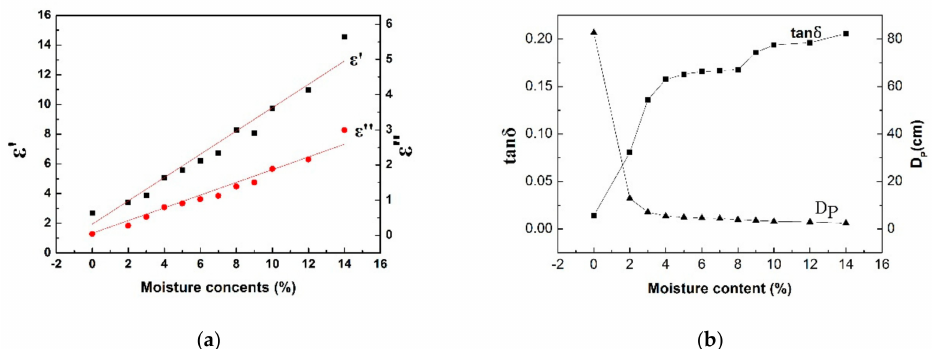
Figure 7. Relative dielectric properties of the NCS for di ff erent moisture contents. ( a ) Relative dielectric constant ( ε (cid:48) ) and relative loss factor ( ε ”) for di ff erent moisture contents. ( b ) dielectric loss angle tangent (tan δ ) and power penetration depth ( DP ) for di ff erent moisture contents.